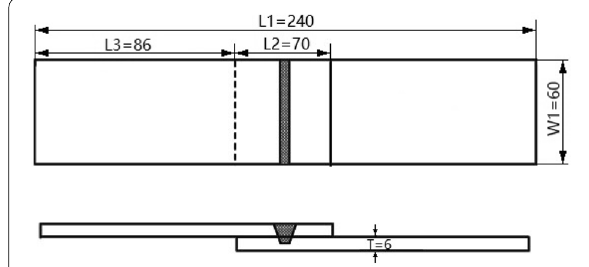
Figure 2 Shape and size of the base metal sample (unit: mm)